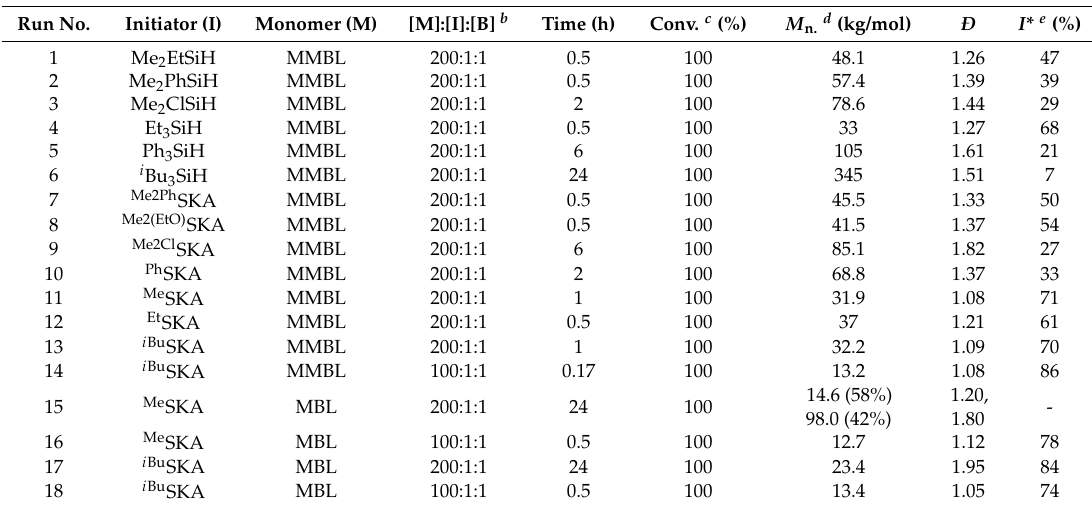
Table 1. B(C 6 F 5 ) 3 -catalyzed polymerization of (M)MBL a .